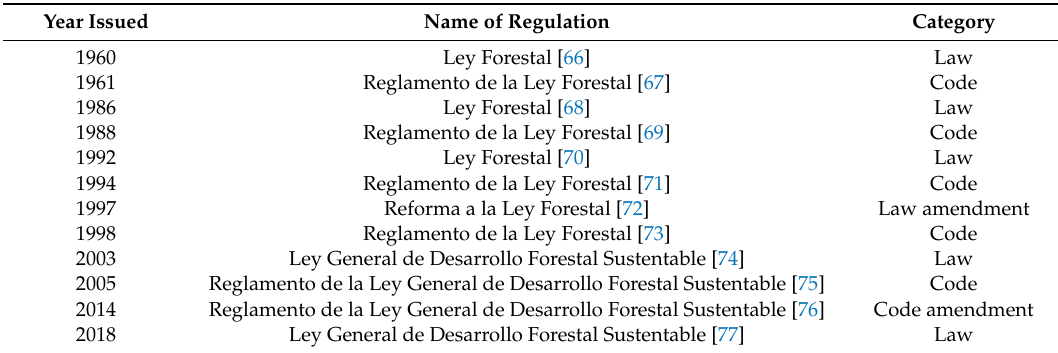
Table 1. Forest laws and codes analyzed for this study. Code ( reglamento in Spanish) is a legal instrument subordinate to a law (ley) that set its specifics. A newly enacted law replaces the old one, an older code is in e ff ect until a new code is enacted.